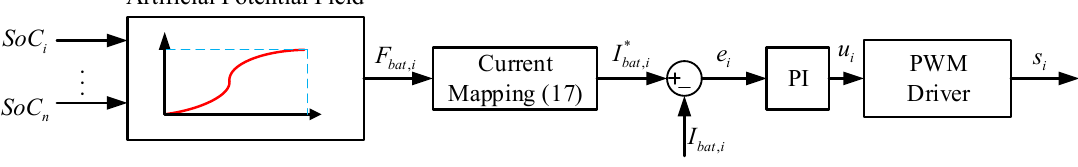
Figure 7. Distributed control strategy incorporating artificial potential field for battery